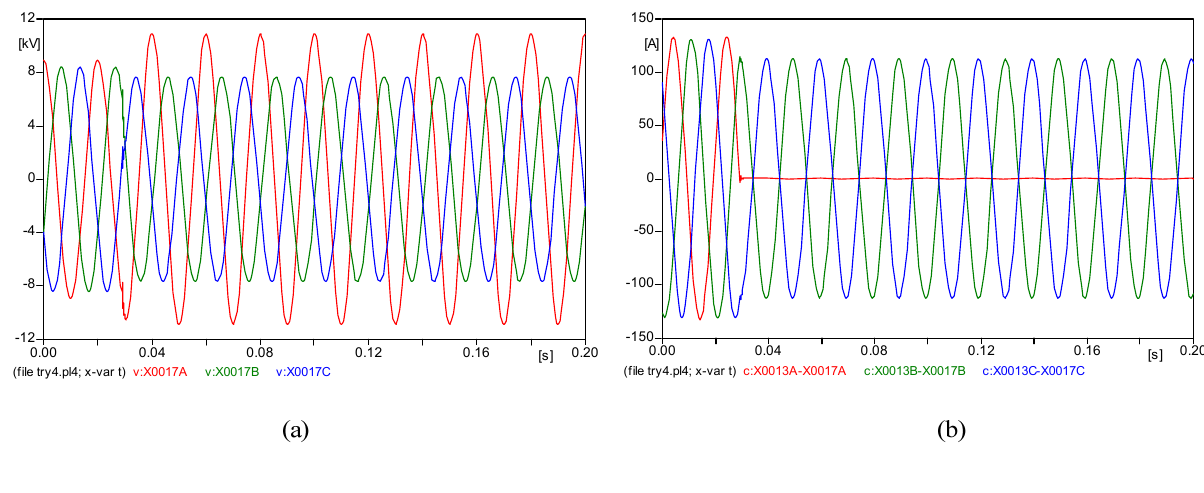
Figure 11. ( a ) Waveform of voltages; ( b ) Waveform of